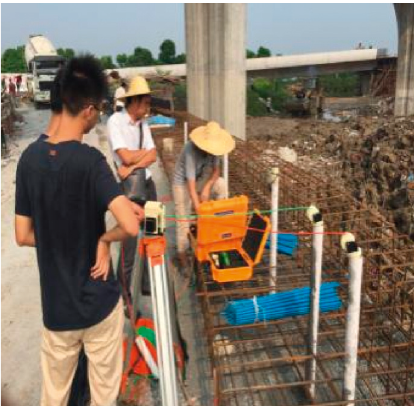
Figure 27: Ultrasonic parameter collection.